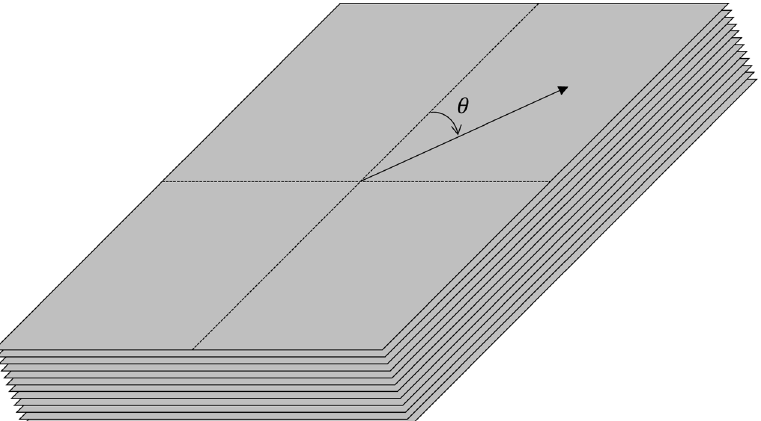
Figure 1. Configuration of simple carbon-fiber-reinforced plastic (CFRP) specimen with (cid:2016) denot- ing the carbon fiber direction, and it consists of 12 layers of pre-implemented composite fibers (USN 250A).